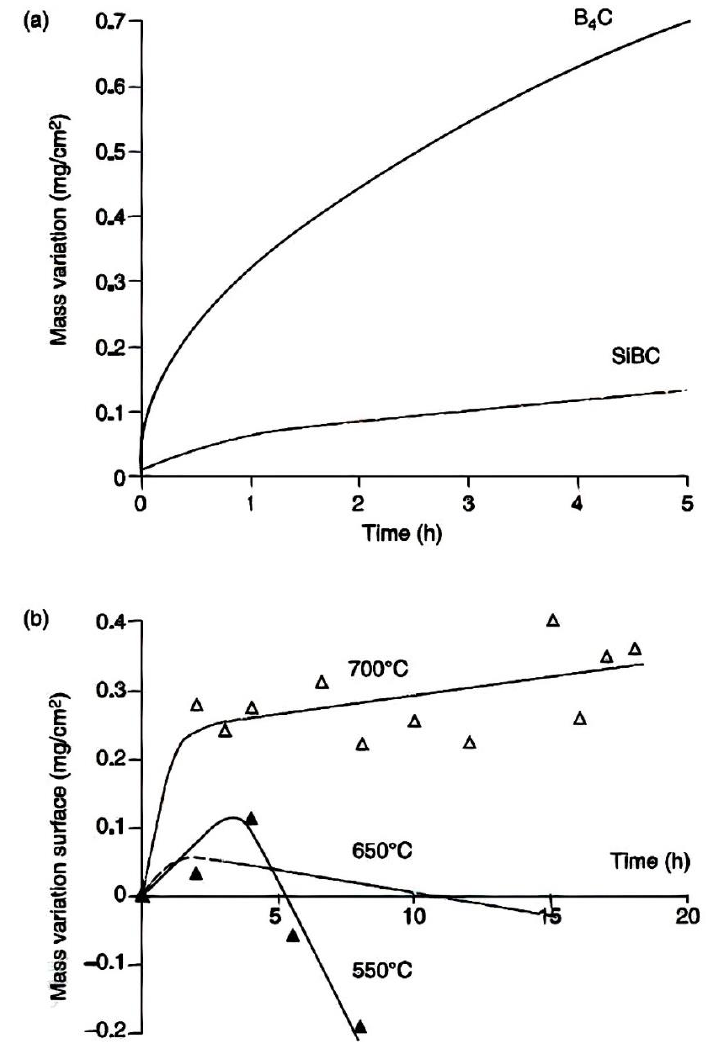
Figure 15. Change in weight during oxidation of SiBC in a furnace under the cold zone [158]. ( a ) Mass variation vs. Time and ( b ) Mass variation surface vs. Time.